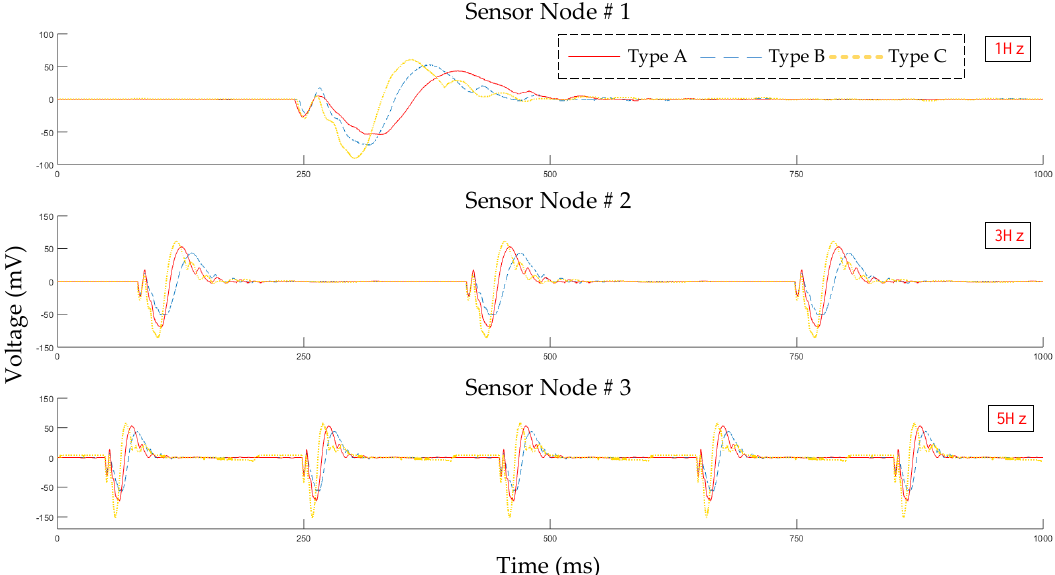
Figure 12. Result signals of oscilloscope from each SN type. Table 1. Vibration testing output.